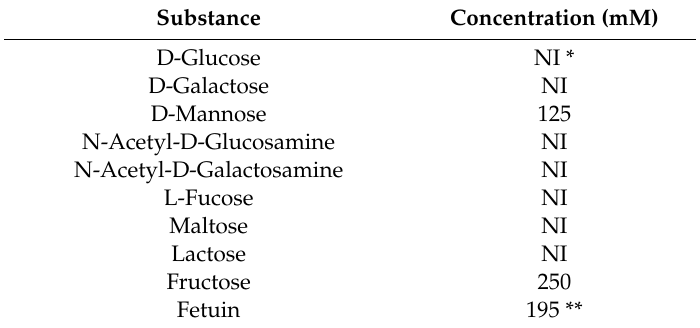
Table 3. Minimum inhibitory concentration of lectin by treatment of various